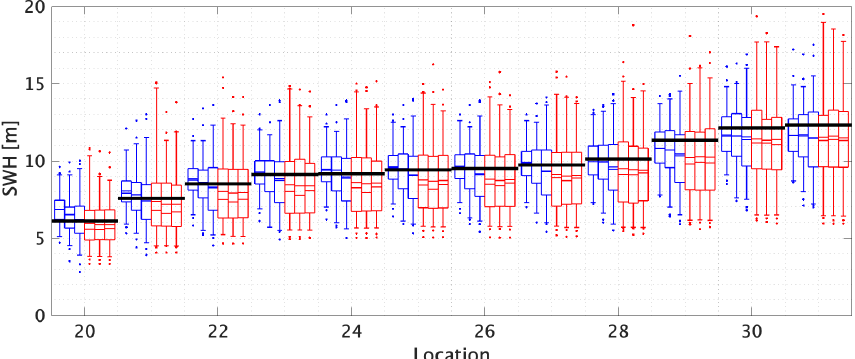
Figure 12. The 100-year return value for SWH using probability-weighted moments for the line transect. The x axis gives the reference numbers of the 12 locations on the transect. Briefly, for each location, blue and red box–whiskers summarize the estimated return value from STM-E and single-location analysis respectively; see caption of Fig. 6 for other details. The black horizontal lines correspond to the empirical estimate of the return value obtained directly from the full synthetic cyclone data for each location. Water depths at the 12 line transect locations are given in the caption to Fig.